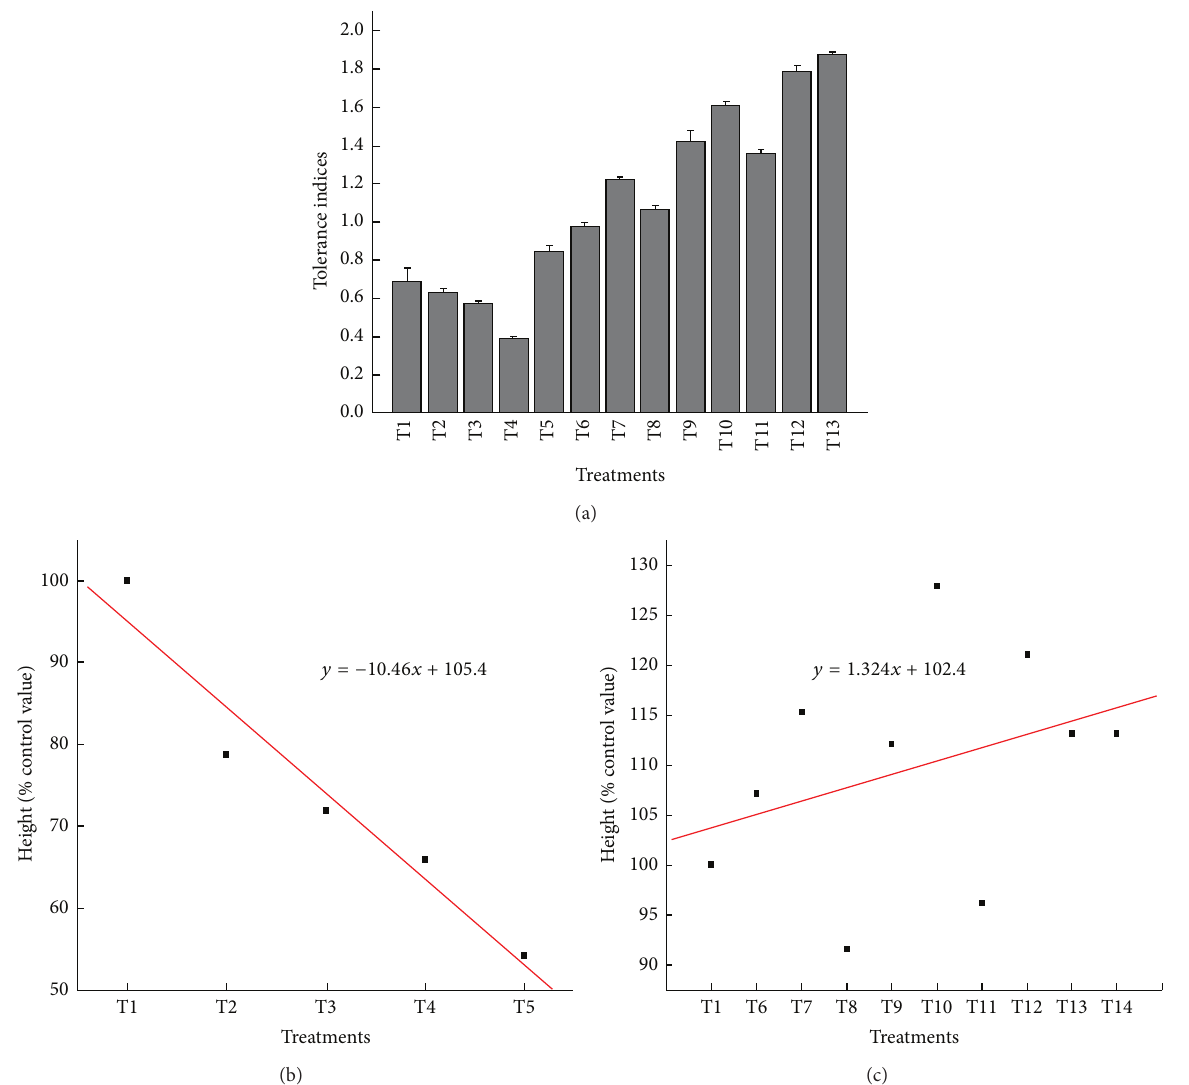
Figure 3: (a) Tolerance indices and percent (b) inhibition and (c) promotion of height of V. mungo under TE treatment with recovery doses of zinc and